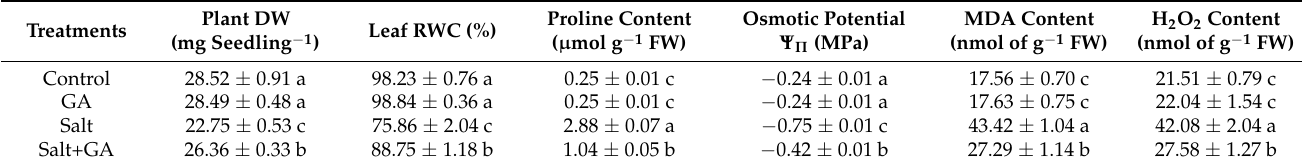
Table 1. Dry weight, leaf RWC, proline content, osmotic potential, MDA content, and H 2 O 2 content of salt-treated rice ( O. sativa L. cv. BRRI dhan52) seedlings as influenced by GA supplementation.